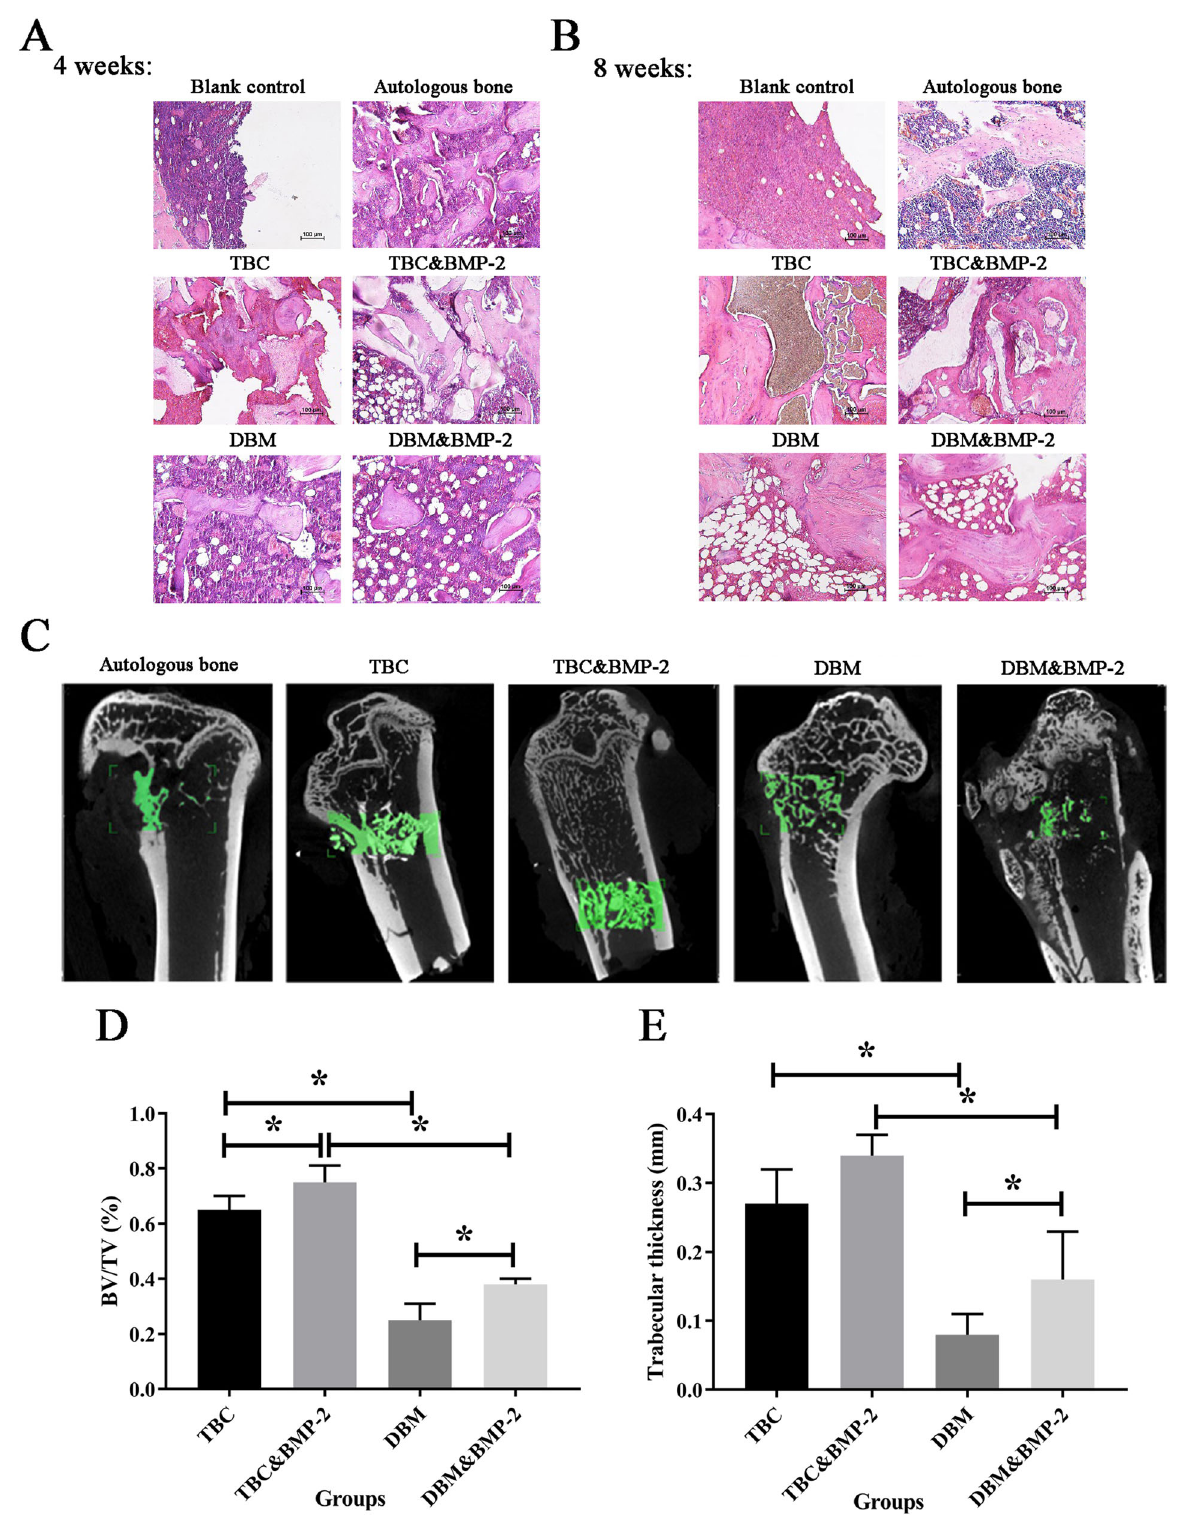
Fig. 2 The repair of femoral condyle defect. A HE staining of 4 weeks; B HE staining of 8 weeks; C Micro-CT scanning of 8 weeks, n = 6; D The bone mass/total volume (BV/TV) scores, n = 6; E The bone trabecular thickness (TT), n = 6. * P <